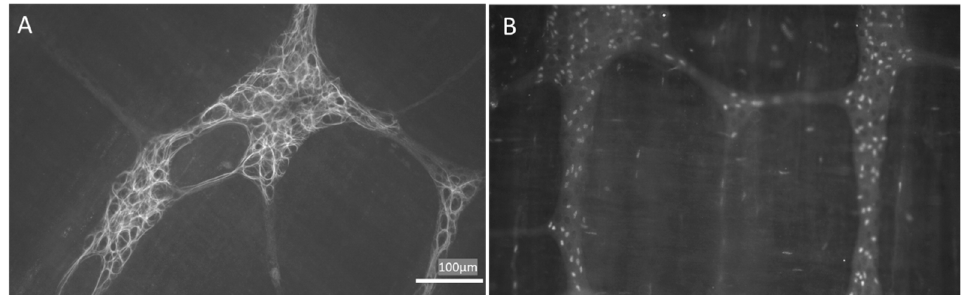
Figure 1. Appearance of enteric glial cells (EGCs). ( A , B ) are images obtained from the myenteric plexus of the rat distal colon; immunoreactivity to GFAP ( A ) and Sox-10 ( B ) are characteristic of EGCs. GFAP: glial fibrillary acidic protein. Images obtained by L.L.-G. (NeuGut-URJC).